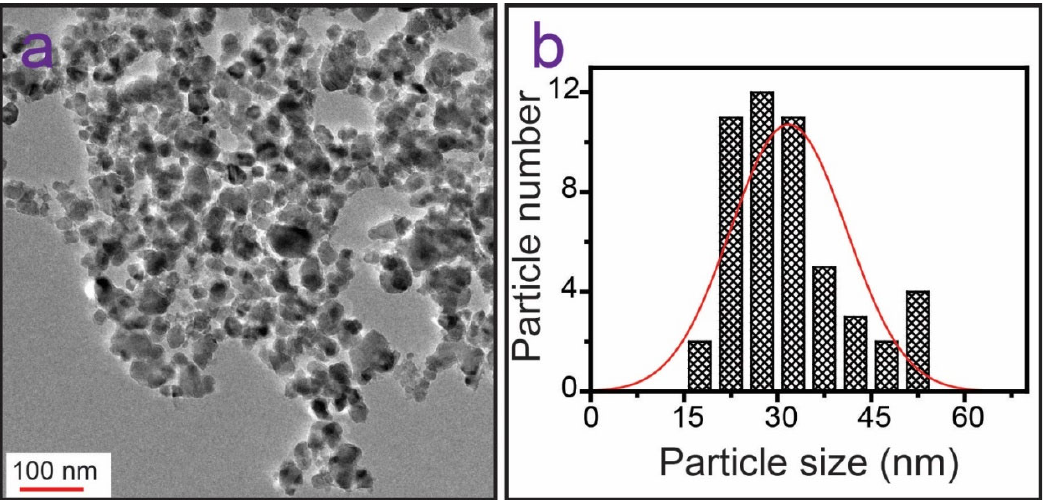
Figure 4. ( a ) TEM image of TiO 2 NPs. ( b ) Particle size distribution graph of TiO 2 NPs (50 particles were counted).